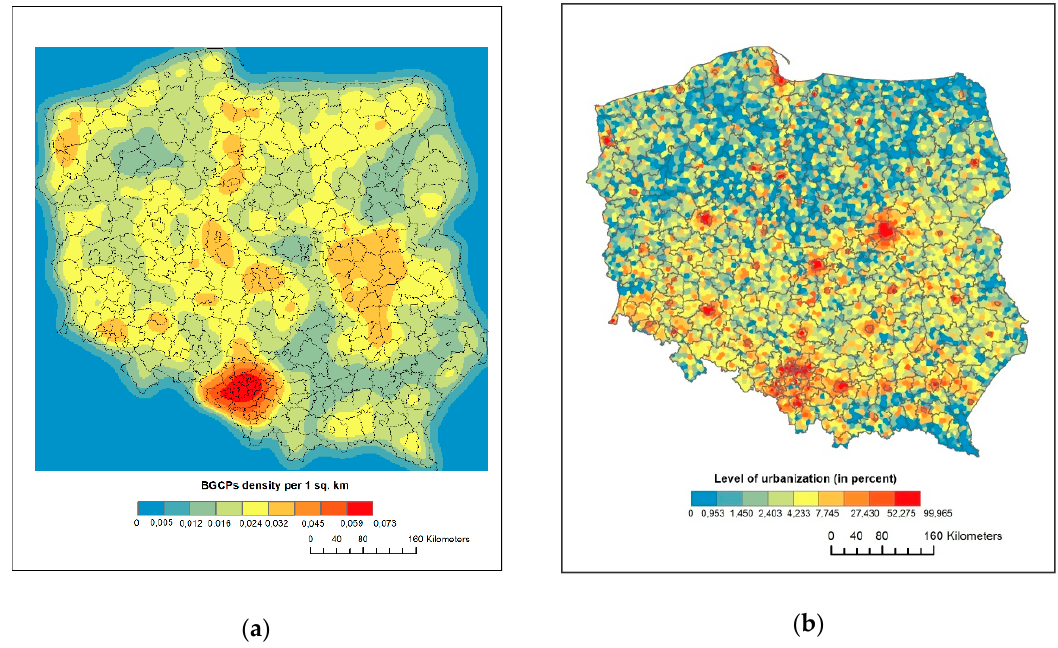
Figure 5. Poland: ( a ) Local density of BGCPs; ( b ) level of urbanization (in percent).